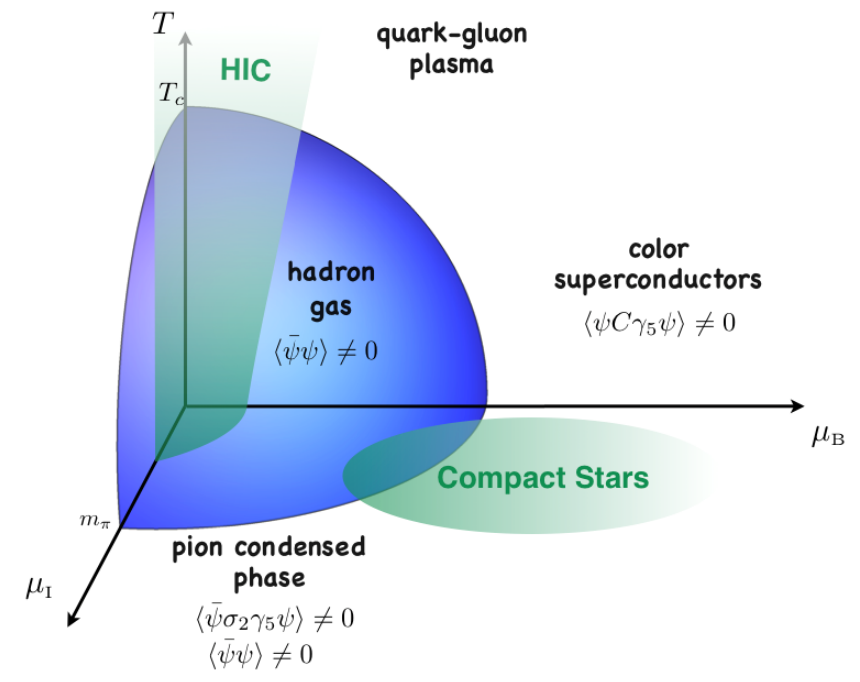
Figure 1. A schematic view of the phase diagram of QCD in the baryon, isospin chemical potential, and temperatures, from Ref. [5]. For two-color QCD the diagram would look similar, but the zero- temperature baryon and isospin critical chemical potential are the same, and the two dense phases are characterised by diquark and pion